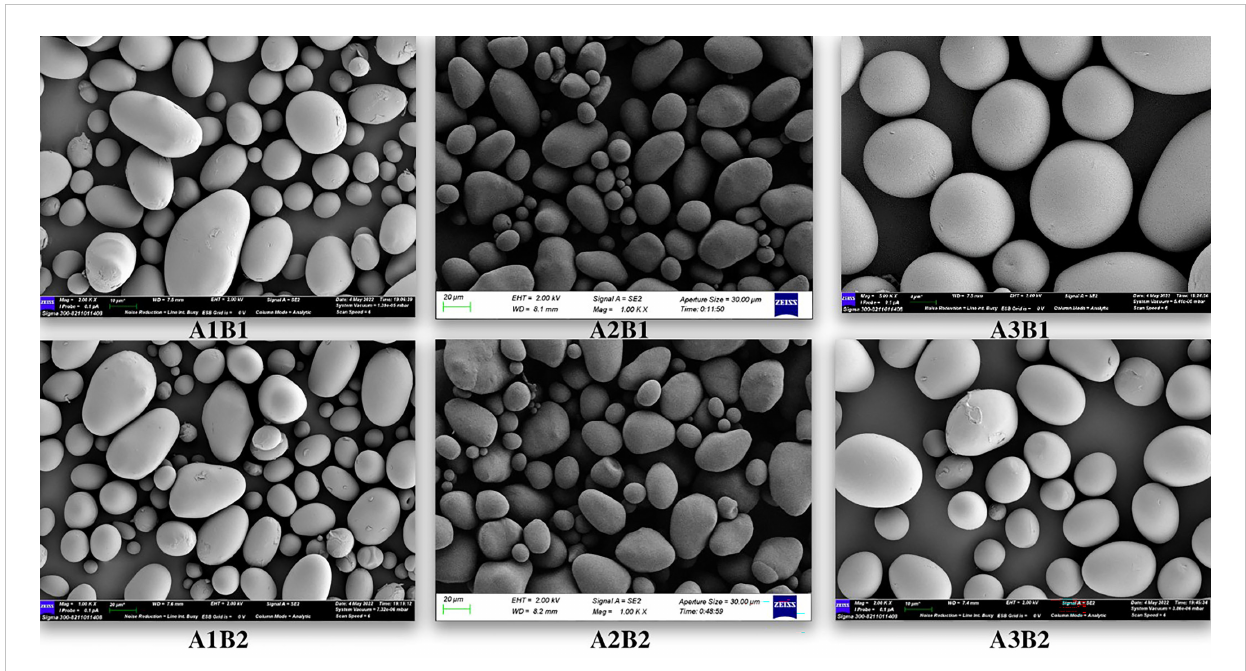
FIGURE 2 Electron microscope scanning images of potato starch granules at different altitudes. A1, A2 and A3 represent Chongzhou, Xichang and Litang respectively, B1 and B2 represent Jiusen No. 1 and Qingshu No. 9.